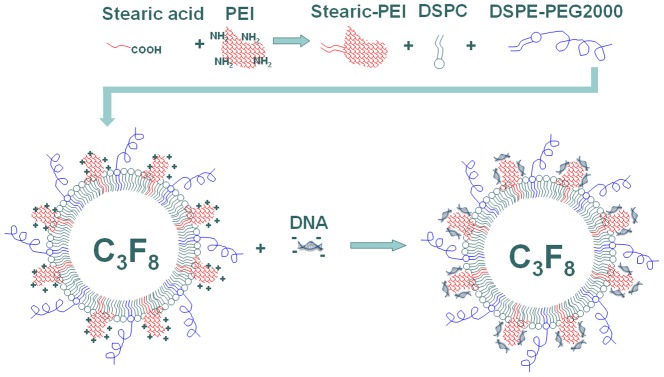
Illustration of the PEI modification by stearic acid for preparing of cationic microbubbles (MBs) to load DNA.The stearic acid modified polyethylenimine 600 (Stearic-PEI) polymer was synthesized. The resulting Stearic-PEI, combined with DSPC and DSPE-PEG2k, was used to fabricate the cationic MBs. The PEI endows the cationic MBs with more amino groups to couple DNA than plain MBs.